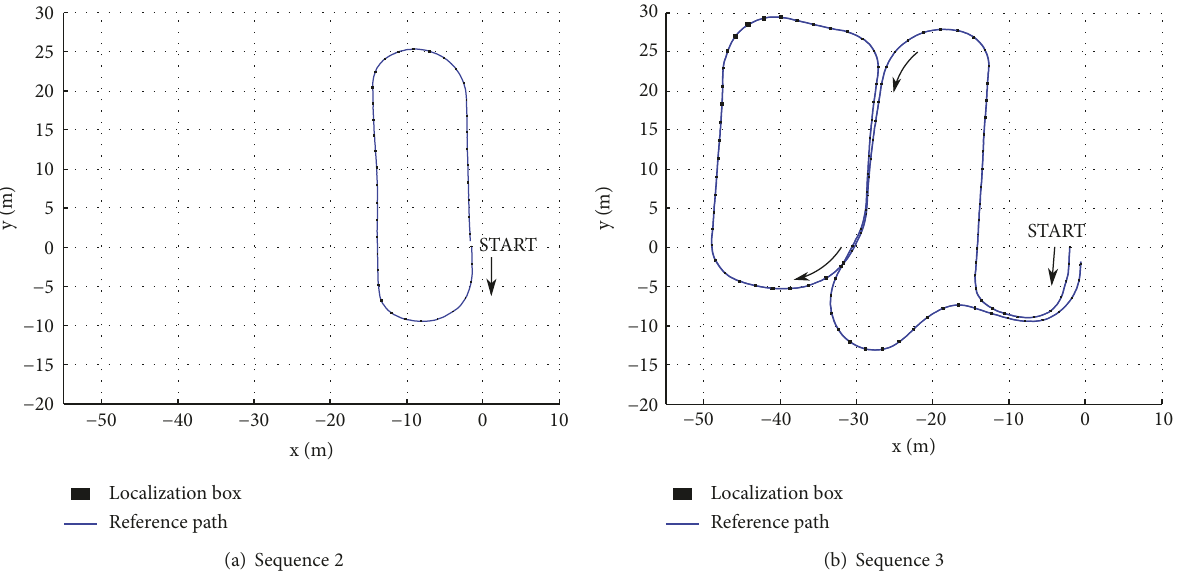
Figure 18: Localization boxes compare with reference path.